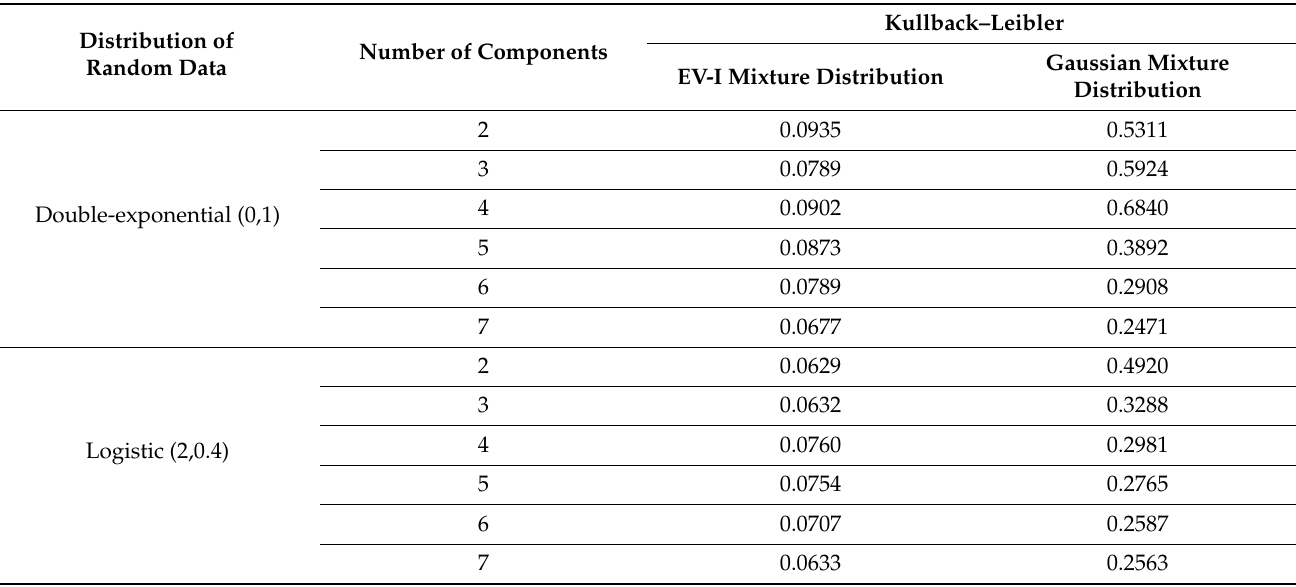
Table 5. Comparison of Kullback–Leibler divergence using EV-I mixture and Gaussian mixture distributions for misspecifi- cation cases